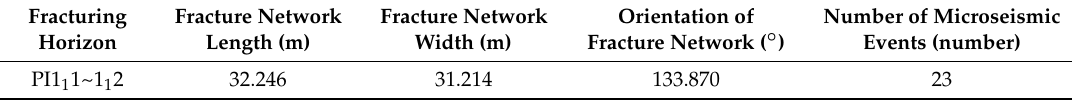
Table 2. Calculation of model parameters.